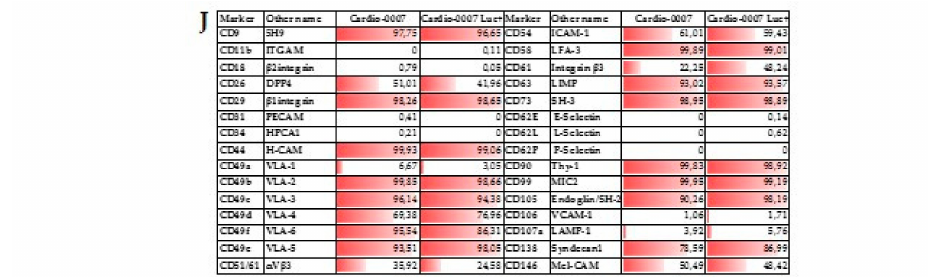
Figure 1. ( A , B ) The culture of Cardio-0007 and Cardio-0007 Luc + (scale bar = 20 µ m). ( C ) The cell imaging with an AMI Imaging System. Cardio-0007 Luc + emits a luminescence